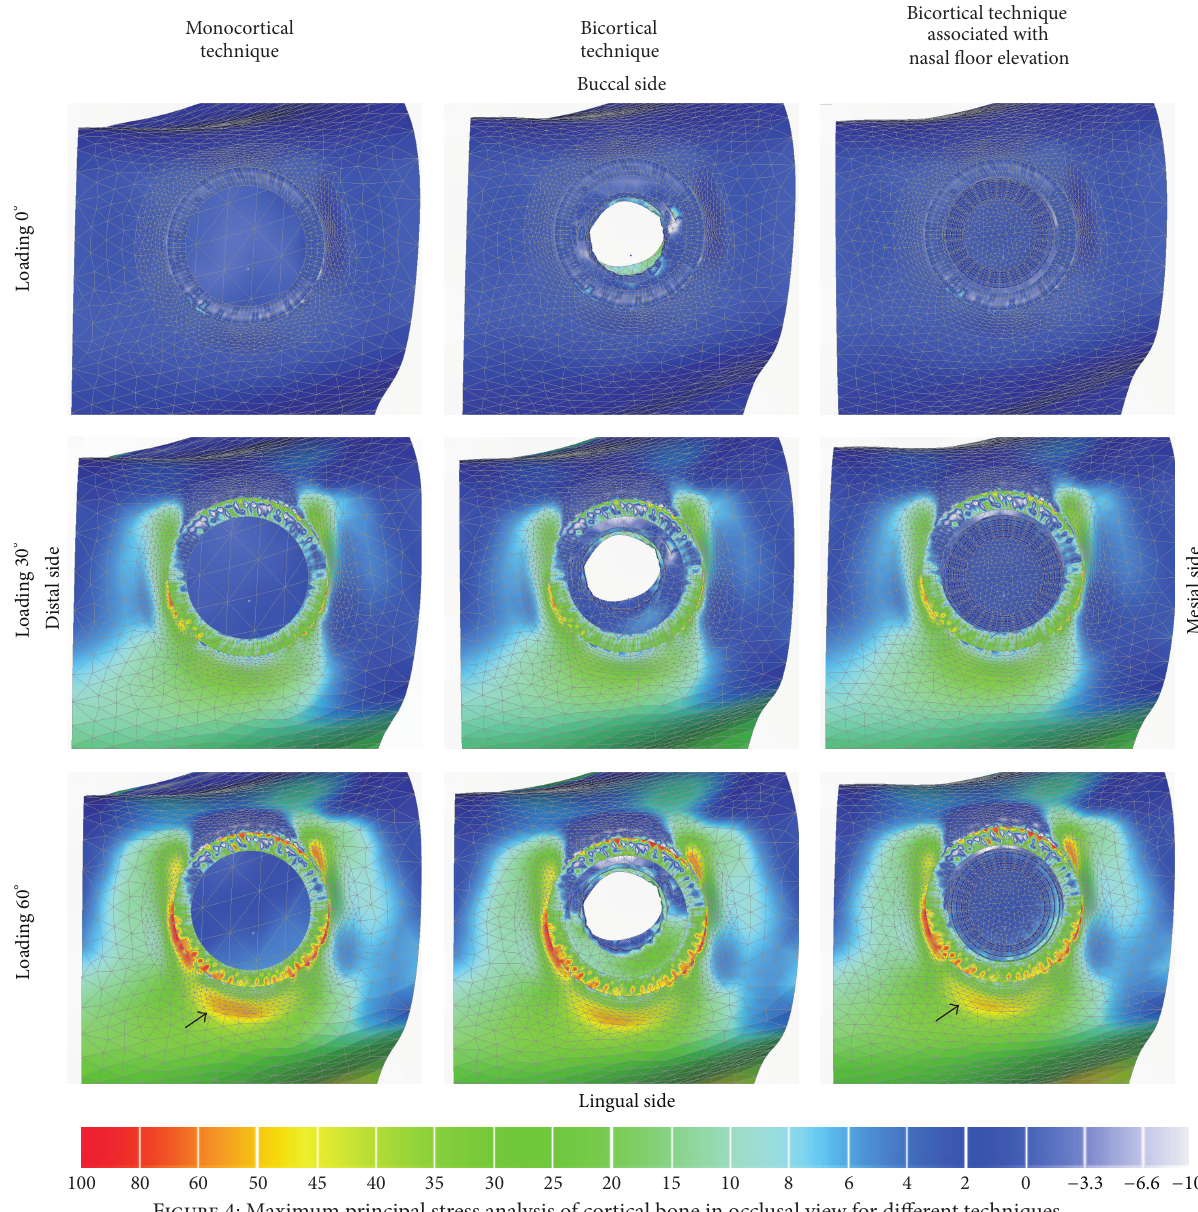
Figure 4: Maximum principal stress analysis of cortical bone in occlusal view for different